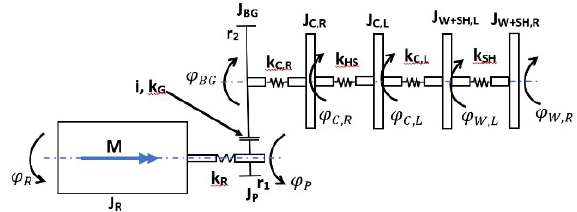
Figure 3. Torsion system scheme – fully-suspended drive [3].